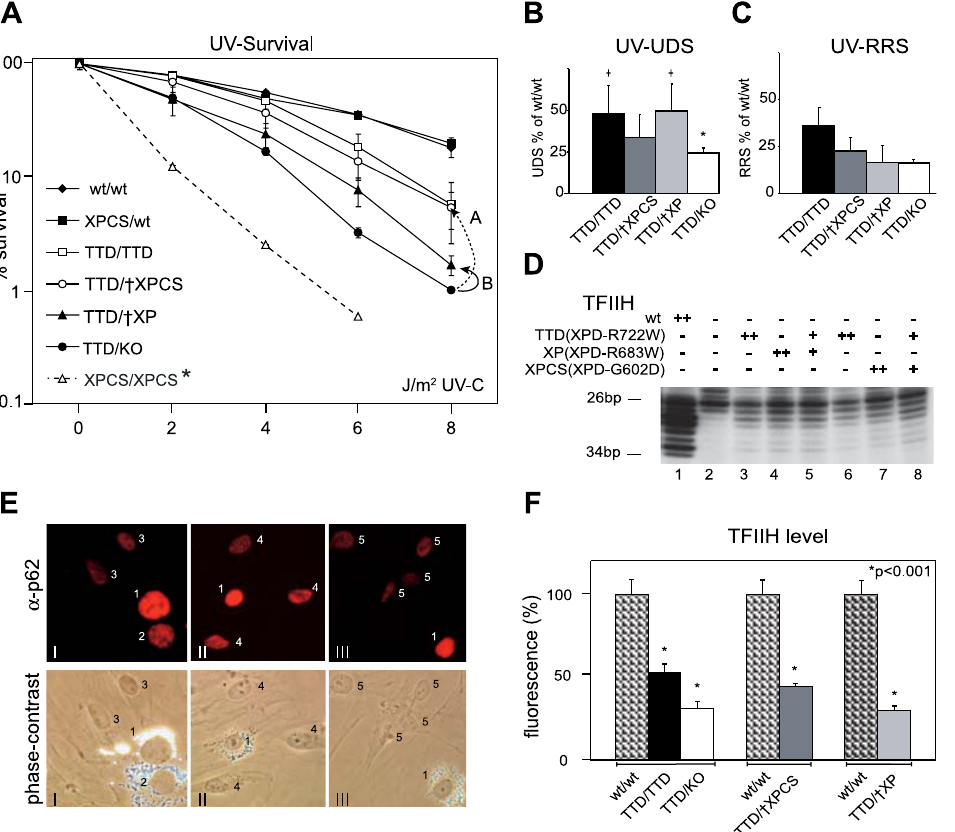
Figure 4. TFIIH Functions and Mechanisms of XPD-Associated Disease Pleiotropy (A) Cellular survival after UV irradiation. Rescue of hemizygous Xpd TTD/KO survival by Xpd (cid:1) XPCS and Xpd (cid:1) XP alleles is illustrated by arrows marked A and B, respectively. UV survival of homozygous Xpd XPCS/XPCS cells (asterisk) from the normally expressed viable allele (Xpd XPCS ) is depicted by a dotted line. Survival curves represent an average of four independent experiments; 1–2 cell lines per genotype were included in each experiment. Error bars indicate SEM between experiments. (B) UV-UDS, a measure of global genome repair. Number of experiments: n ¼ 15 (Xpd TTD/TTD ), n ¼ 6 (Xpd TTD/KO ), n ¼ 4 (Xpd TTD/ (cid:1) XPCS ) , n ¼ 2 (Xpd TTD/ (cid:1) XP ); 1–2 cell lines per genotype were included in each experiment. The asterisk indicates significant difference with Xpd TTD/TTD ; crosses indicate significant differences with Xpd TTD/KO . (C) UV-RRS,ameasureoftranscription-coupledrepairofUV-inducedlesions.Numberofexperiments: n ¼ 7 (Xpd TTD/TTD ),n ¼ 2 (Xpd TTD/KO ),n ¼ 4 (Xpd TTD/ (cid:1) XPCS ) , n ¼ 2 (Xpd TTD/ (cid:1) XP ) ; 1–2 cell lines per genotype were included in each experiment. (D) Incision/excision activity of combinations of altered TFIIH complexes in a reconstituted NER reaction. Equal amounts of single or mixed populations of recombinant TFIIHs (containing XPD, XPB, p62, p52, His-p44, Flag-p34, cdk7, cyclin H, Mat1, and p8) were mixed with recombinant XPG, XPF/ERCC1, XPC/hHR23B, RPA, and a radiolabelled synthetic NER substrate. The excision products (26–34 nucleotides in length) were visualised at nucleotide resolution on a denaturing polyacrylamide gel as indicated . Note the weak activity corresponding to each single and combined TFIIH complex (lanes 3– 8) relative to the wt (lane 1) and negative controls (lane 2). (E) Xpd dose-dependent reduction of TFIIH in homozygous Xpd TTD/TTD , hemizygous Xpd TTD/KO , and compound heterozygous Xpd TTD/ (cid:1) XPCS and Xpd TTD/ (cid:1) XP cells by comparative immunofluorescence of the p62 subunit of TFIIH. Roman numerals represent different microscopic slides and Arabic numerals different cell lines labelled as follows: (I) wt cells (1) labelled with 2- l m beads, Xpd TTD/TTD cells (2) with 0.79- l m beads, and Xpd TTD/KO cells (3) with no beads; (II) wt cells (1) labelled with 0.79- l m beads and Xpd TTD/ (cid:1) XPCS cells (4) with no beads; and (III) wt cells (1) labelled with 0.79- l m beads and Xpd TTD/ (cid:1) XP cells (5) with no beads. (F) Quantification of immunofluorescent signal from at least 50 nuclei per cell line and 2–6 experiments per genotype. Bars representing cells analysed on the same microscopic slide are depicted side by side, with wt set at 100%. The p -value indicates minimum significant difference between wt and the indicated cell lines analysed on the same microscopic slide within one experiment. DOI: